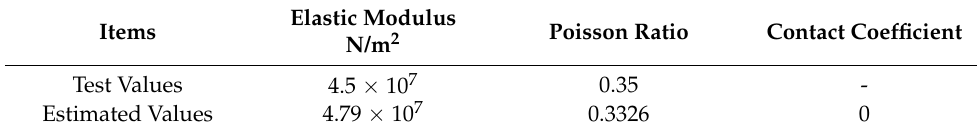
Table 3. Comparison between the identified values and the test values for soil parameter. Elastic Modulus Items Poisson Ratio Contact Coefficient N/m 2 Test Values 0.35 - Estimated Values 4.79 × 10 7 0.3326 Figure 7. The comparison between the theoretical wavenumbers and the field test wavenumbers. ( a ) Real part; ( b ) Imaginary part.